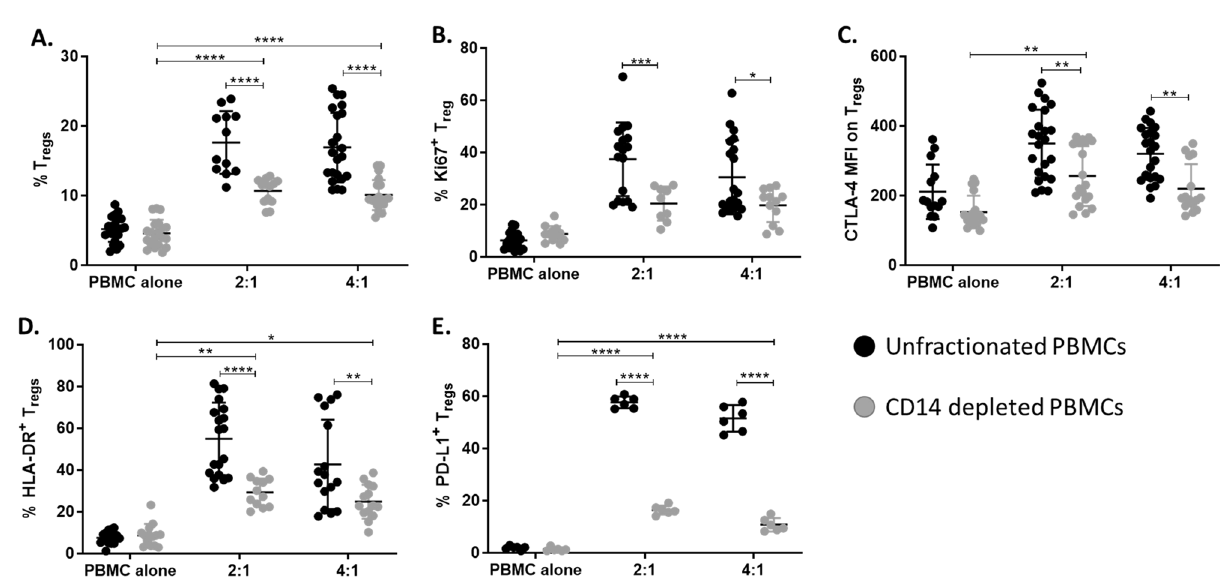
Figure 6. CD14 + monocytes are required for optimal MAPC cell induction of Tregs. ( A ) Quantification of Treg percentages after 7-day co-culture of unfractionated PBMCs (black) or CD14 depleted PBMCs (grey) with MAPC cells. Graphs showing quantification of ( B ) Ki67, ( C ) CTLA-4, and ( D ) HLA-DR, and ( E ) PD-L1. Data represent mean ± SD from pooled samples of five independent experiments with 3 PBMC and 3 MAPC cell donors. Statistical analysis was performed using Two-way ANOVA with a Sidak’s multiple comparisons test (****p < 0.0001, ***p < 0.001; **p < 0.01, and *p <